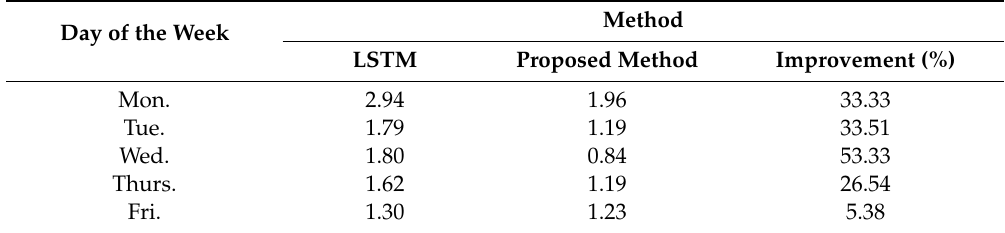
Table 1. MAPE of LSTM and proposed method for the week of 15 to 19 March 2010.